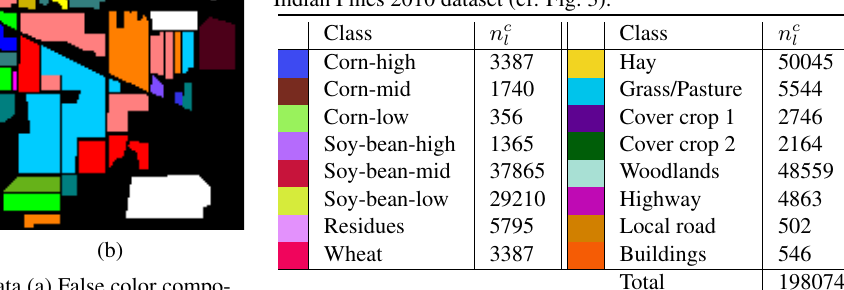
Table 2: Classes and Samples ( n c Indian Pines 2010 dataset (cf. Fig. 3).